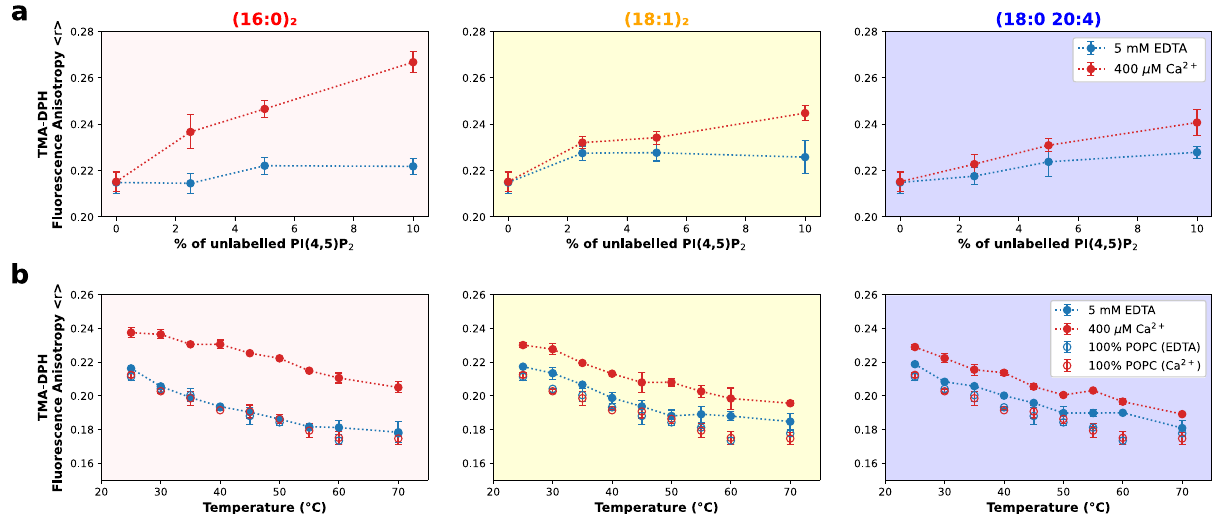
Fig. 3 TMA-DPH fl uorescence spectroscopy shows that calcium-induced PI(4,5)P 2 nanodomains are more ordered than monodisperse PI(4,5)P 2 , even for unsaturated acyl-chain compositions. PI(4,5)P 2 local membrane order was determined through the incorporation of TMA-DPH at a 1:300 lipid ratio in MLVs containing POPC and increasing concentrations of unlabeled PI(4,5)P 2 . The experiments were done for the three acyl-chain compositions in study. For all acyl-chain compositions analyzed here, an increase in local membrane order takes place upon Ca 2 + -induced PI(4,5)P2 nanodomain formation ((16:0) 2 PI(4,5)P 2 : F(1,16) = 148.3, p = 0.0001; (18:1) 2 PI(4,5)P 2 : F(1,16) = 19.71, p = 0.0004; (18:0 20:4) PI(4,5)P 2 : F(1,16) = 12.23, p < 0.0030). TMA- DPH fl uorescence anisotropy ( <r> ) ( a ) was measured in the presence (400 µ M Ca 2 + , red) and absence (5 mM EDTA, blue) of calcium. The TMA-DPH response to a temperature gradient ( b ) was measured in samples composed of POPC:PI(4,5)P 2 95:5. Pure POPC samples were measured as controls. All samples were measured both in the presence and absence of calcium. Error bars for all measurements represent the SD from N = 3 independent